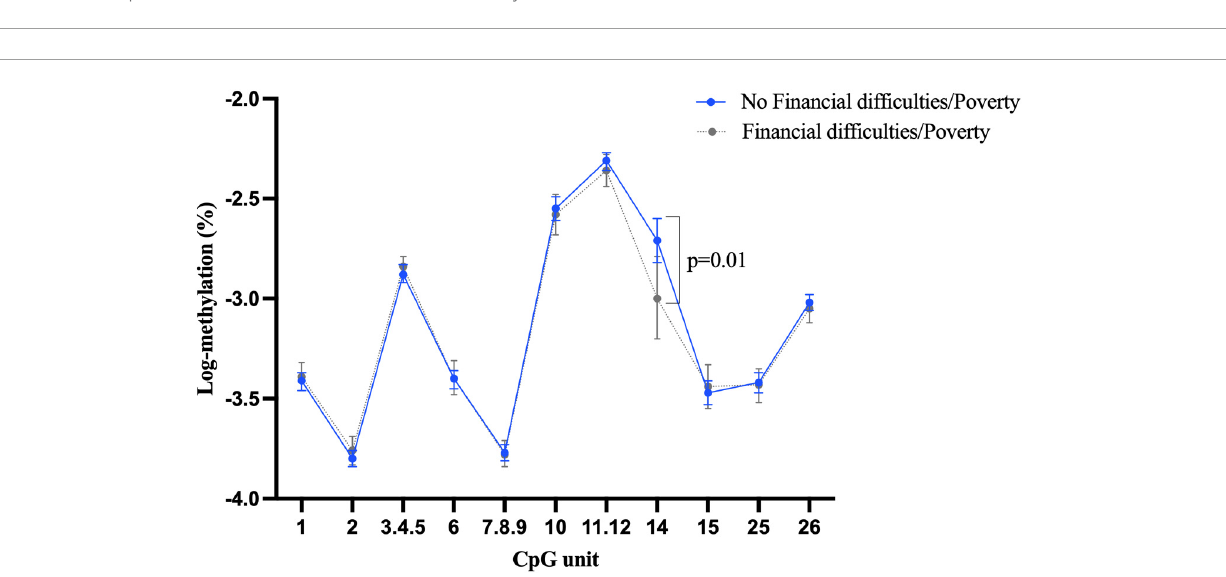
FIGURE3 Childhood experience of financial difficulties/poverty and BDNF methylation at exon I in blood